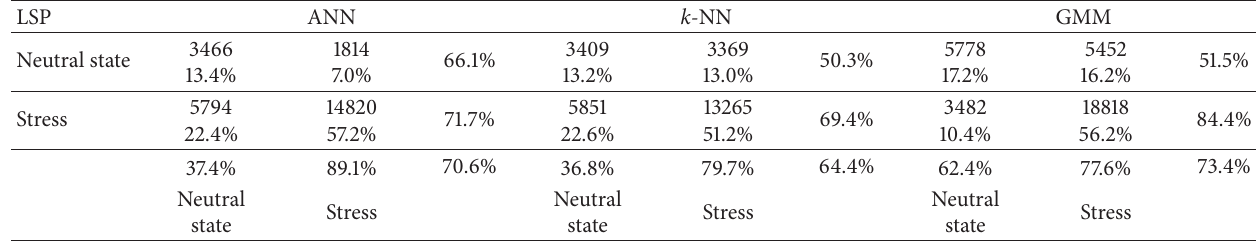
Table 3: Performance results of classifiers for LSP features.